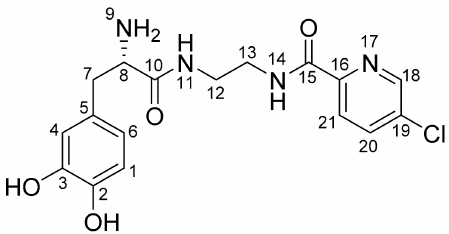
Figure 4. Atom numbering scheme for the L -dopa–lazabemide